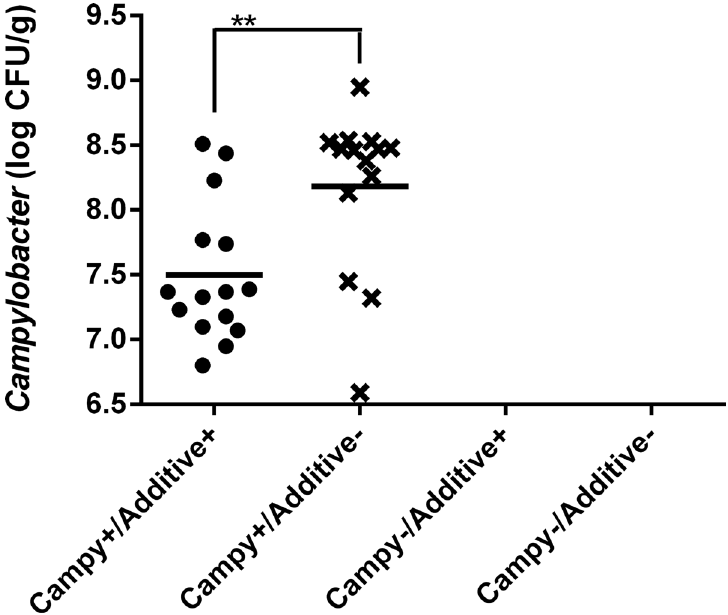
Fig 1. Campylobacter caecal counts in chickens at 35 days of age. No Campylobacter could be detected for the Campy- groups; each point represents the caecal content of a single chicken; horizontal bars illustrate the mean for each group; insufficient caecal matter was recovered from some chicken to allow the enumeration of C . jejuni ; ** indicates p <